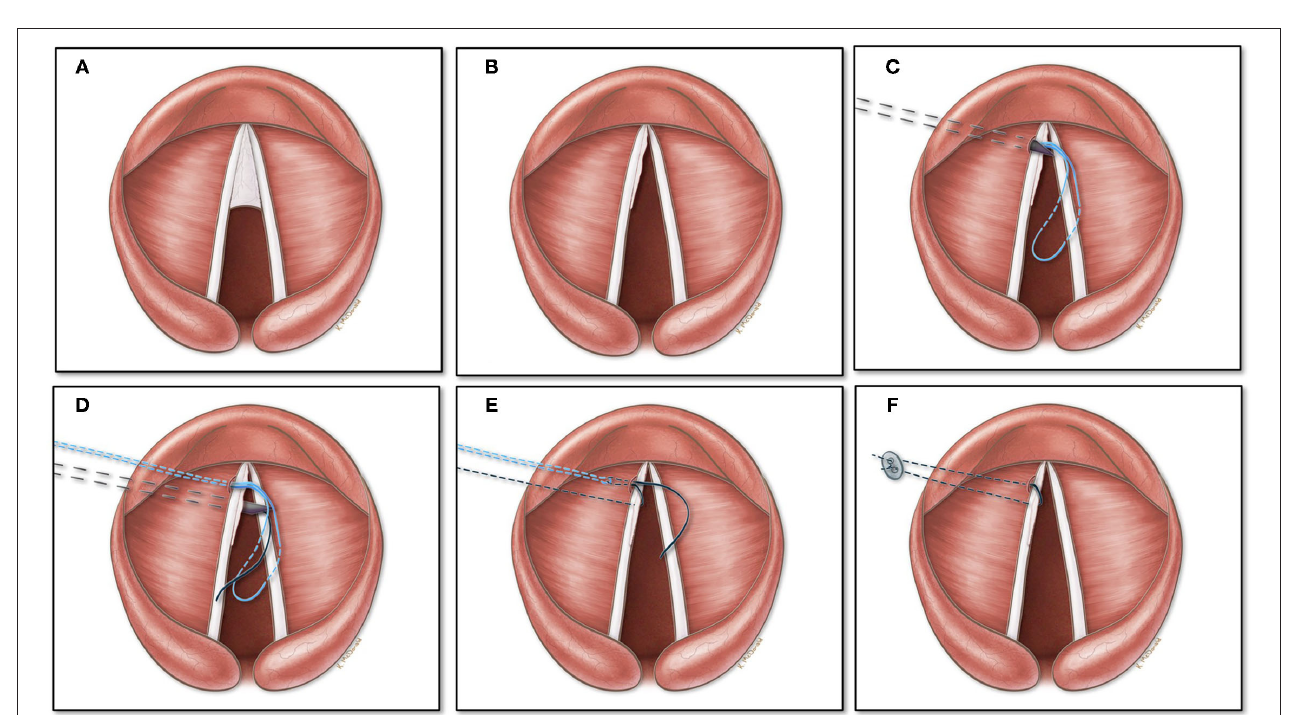
FIGURE 2 | Mucosal flap laterization for laryngeal web: (A) Schematic view of Type 2 laryngeal web. (B) Remnant mucosal flap after unilateral laser incision of the laryngeal web. (C) An 18-gauge needle with a pre threaded looped 3–0 prolene suture is passed under ultrasonographic guidance targeting superior to the true vocal fold near the anterior commissure and is pulled out endolaryngeally. (D) A 20-gauge needle with a 3–0 prolene suture is placed immediately inferior to the true vocal cord under ultrasound guidance and threaded into the loop. (E,F) The looped stitch is pulled out through the neck, which carries the single stitch out, placing the suture with the mucosal flap wrapped on the left vocal